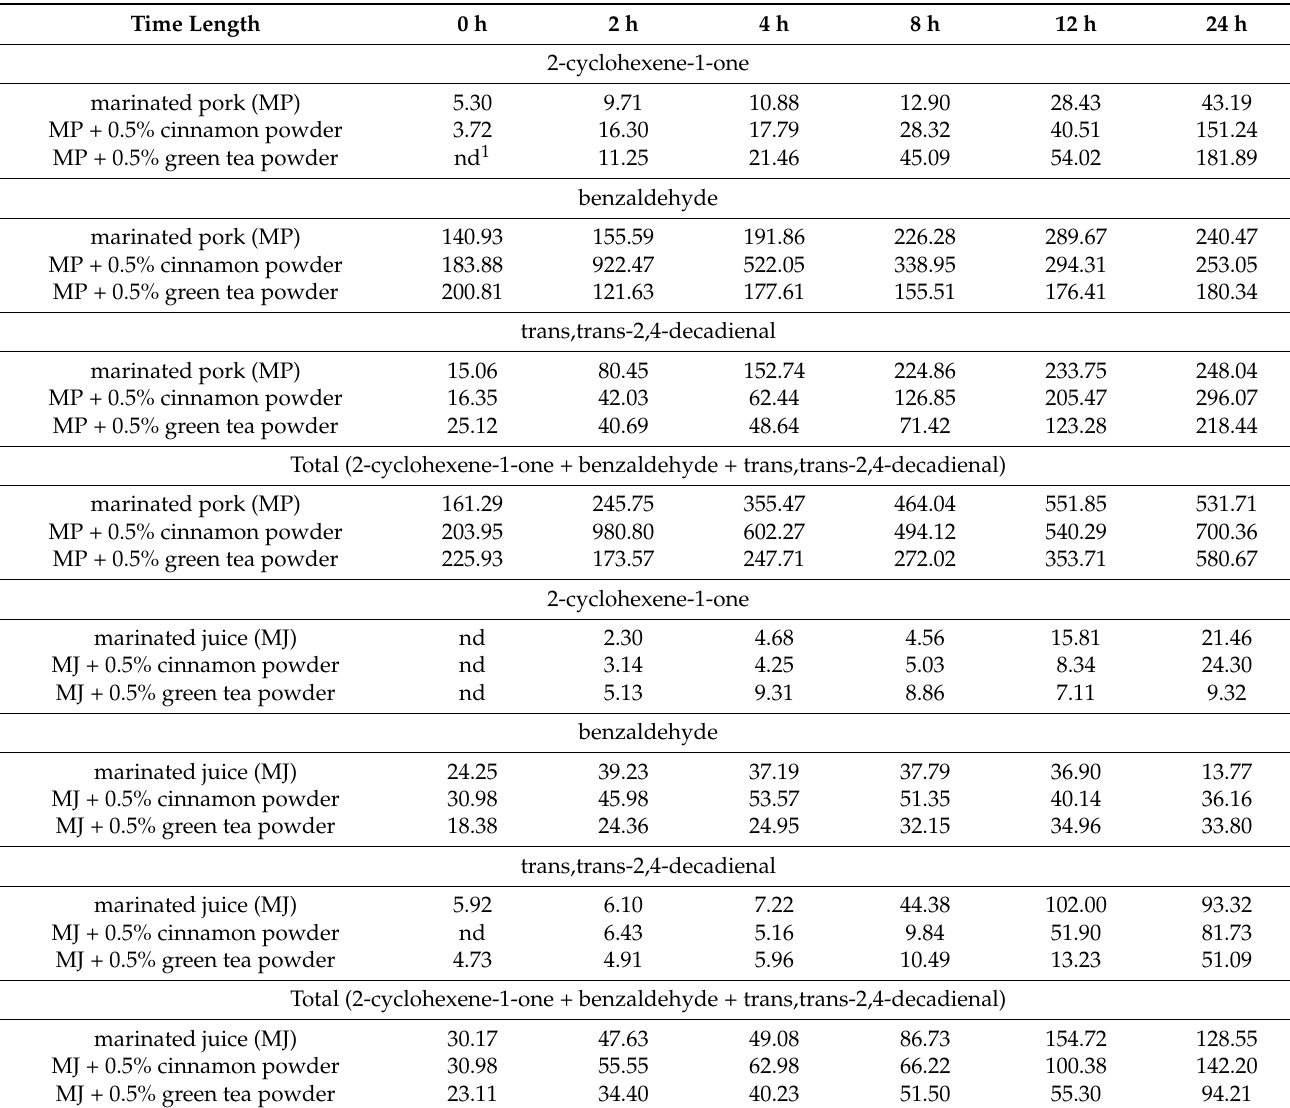
Table 7. Changes of PAH precursor contents (ng/g) in unmarinated/marinated pork and juice as affected by different flavorings and time